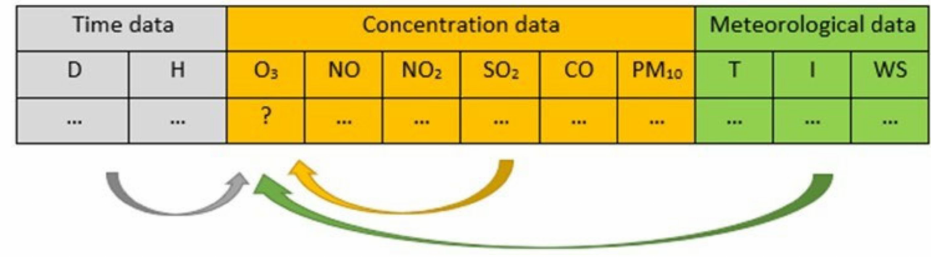
Figure 1. The pattern of regression modeling shows the concept for O 3 prediction.